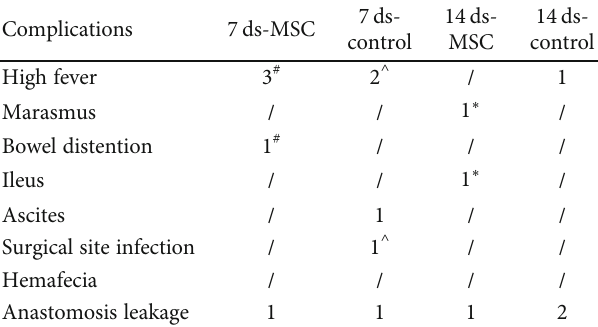
Table 1: Postoperative complications in the